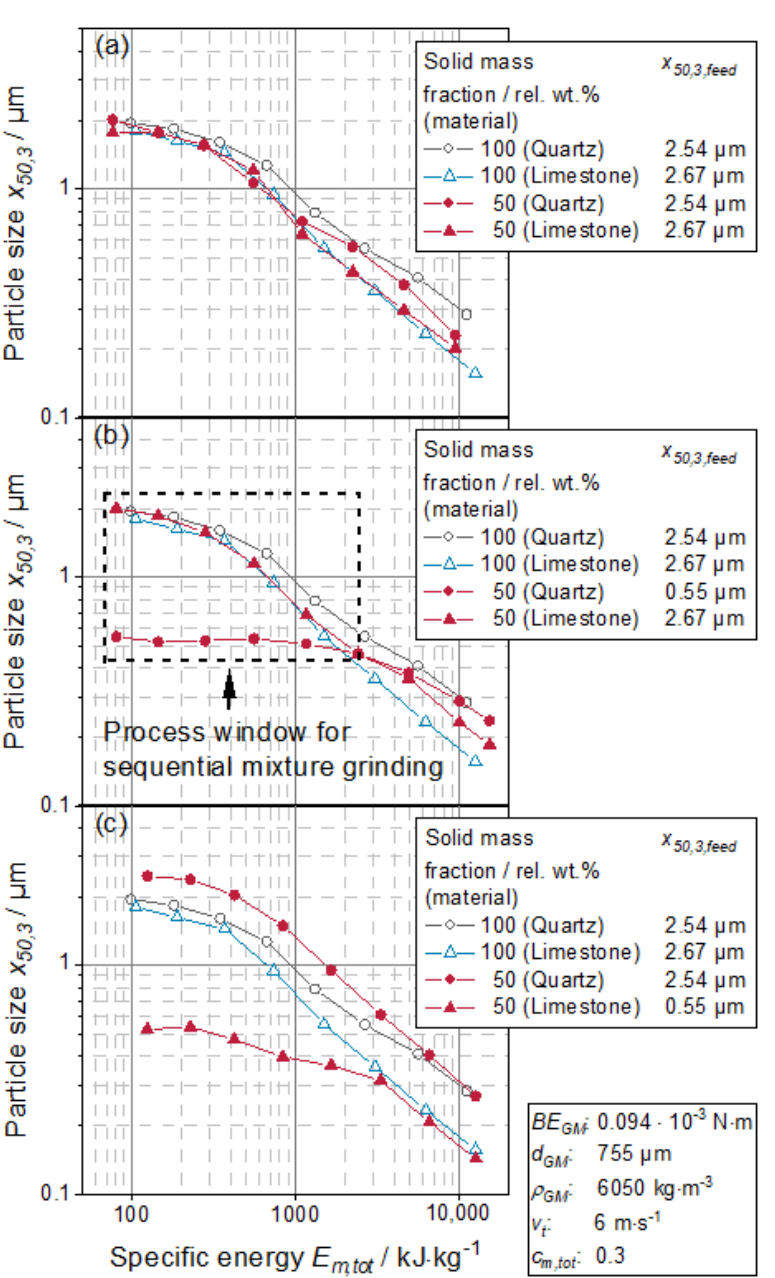
Figure 8. Influence of the initial particle size ratio of quartz and limestone on the component-specific grinding behavior with varied feed particle size x 50,3,feed of both components.